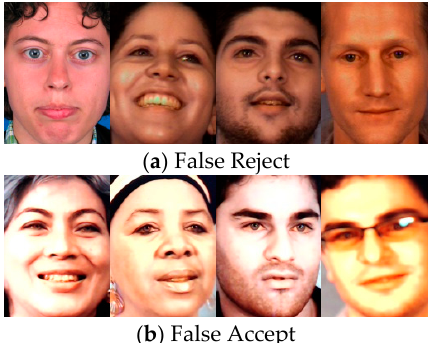
Figure 15. Samples of detection error cases. ( a ) False reject case images; and ( b ) False reject case images. It is observed that face samples with blue eyes more often resulted in false reject error. Table 2. Experimental results for spoofing face detection under a single shot condition.